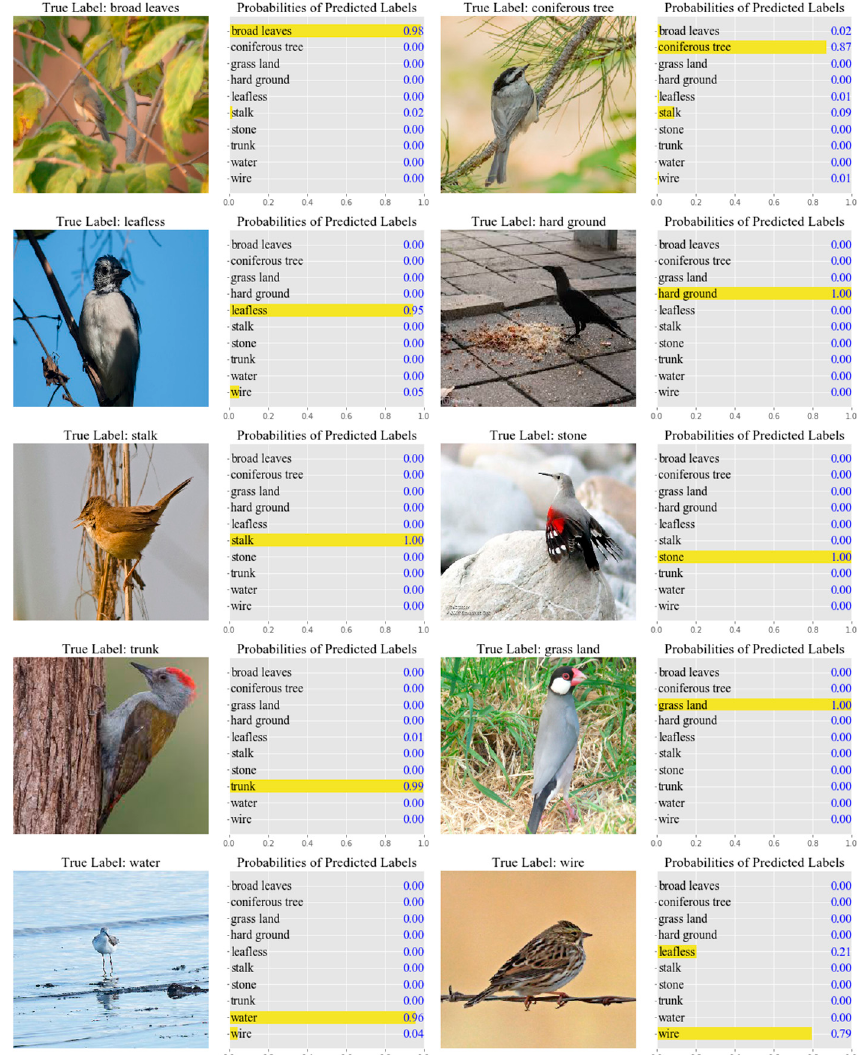
Figure 6. The predictions given by AlexNet for the images in the test set. The real labels and the top 10 predictions are shown. The number beside each label indicates the corresponding probability or prediction confidence. For each image, the sum of the probability values of all its corresponding tags is equal to 1, and this was determined by the activation function used in the proposed algorithm.